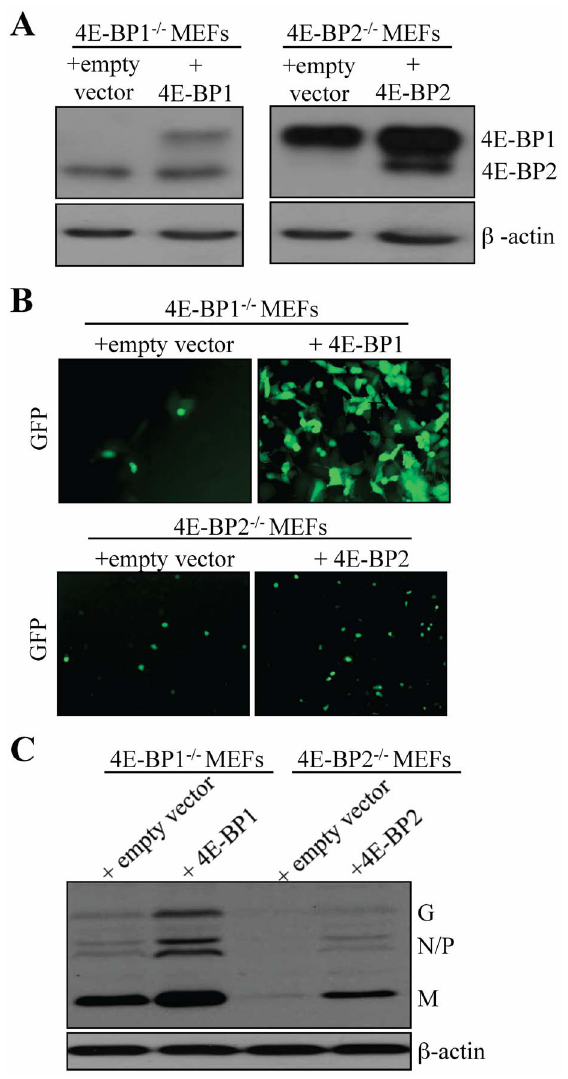
Fig. 5. Exogenous expression of 4E-BP1 or 4E-BP2 in respective 4E-BP1 2 / 2 or 4E-BP2 2 / 2 MEFs increases susceptibility to VSV infection. (A) 4E-BP1 2 / 2 and 4E-BP2 2 / 2 MEFs were transduced with retroviruses carrying an empty vector (control), or retroviruses expressing either 4E-BP1 or 4E-BP2. Western blotting analysis for exogenous expression of 4E-BP1 and 4E-BP2 in their respective single knockout MEFs. (B) Control and transduced MEFs were infected with VSV-GFP at a MOI of 1 PFU/cell and viral infection was assessed by GFP fluorescence and by (C) Western blotting analysis for VSV viral protein